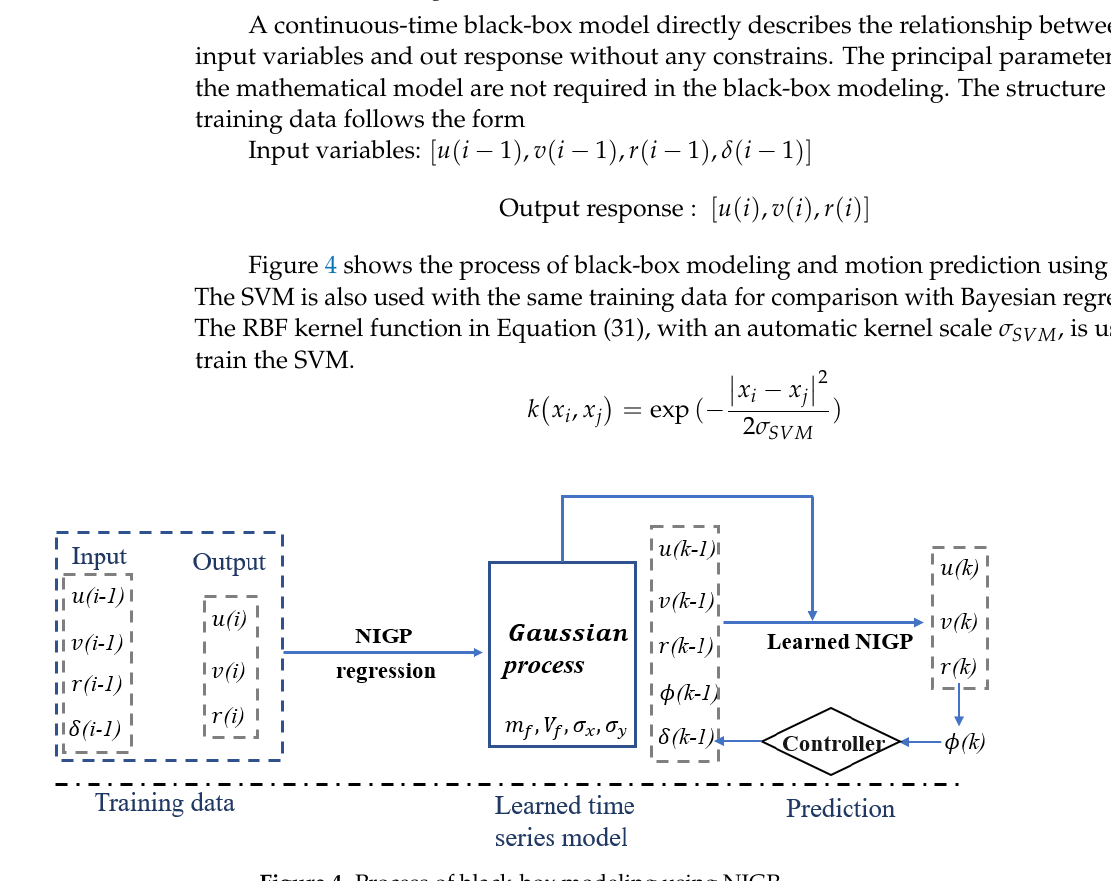
Figure 4. Process of black-box modeling using NIGP.